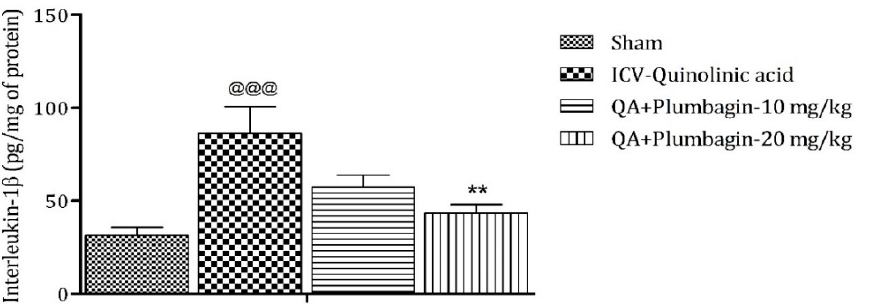
Figure 11. Effect of plumbagin on QA-induced variations in level of IL-1 β in rats. Data represent mean ± SEM ( n = 6). @@@ p < 0.001 as compared to sham group; ** p < 0.01 as compared to QA-induced group.